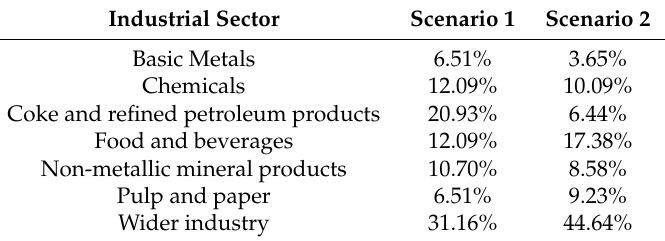
Table 2. Proportion of non-electric heat demand by industrial sector for the two Heat Scenarios